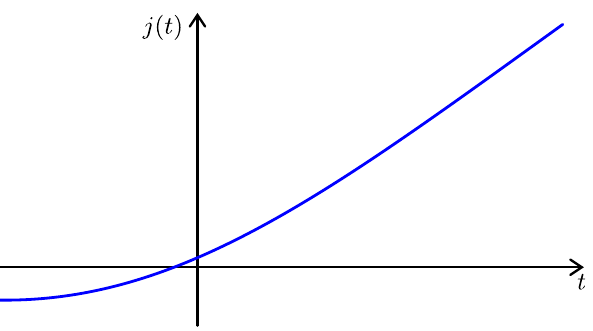
Figure 1 . Expected shape of the leading Regge trajectory in QFT. At large positive t it is linear while at large negative t it approaches a constant. (As far as we know, the transition could be smooth or first order. Here, the origin of the axes is